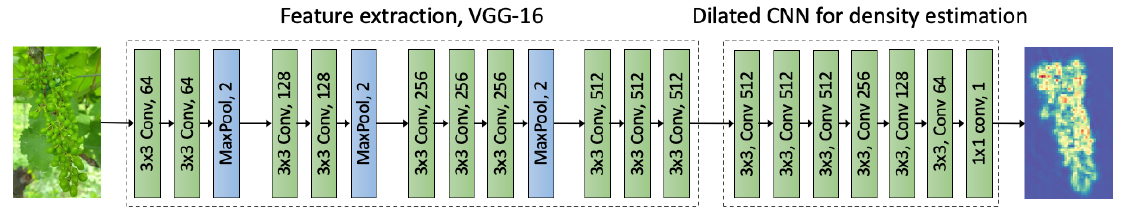
Figure 1. GBCNet architecture: the model takes in-field smartphone images as the input and estimates a density map in which the integral represents berries count. The second block uses a dilation factor of 2. Every convolutional layer is followed by a ReLU operation, except for the last one.